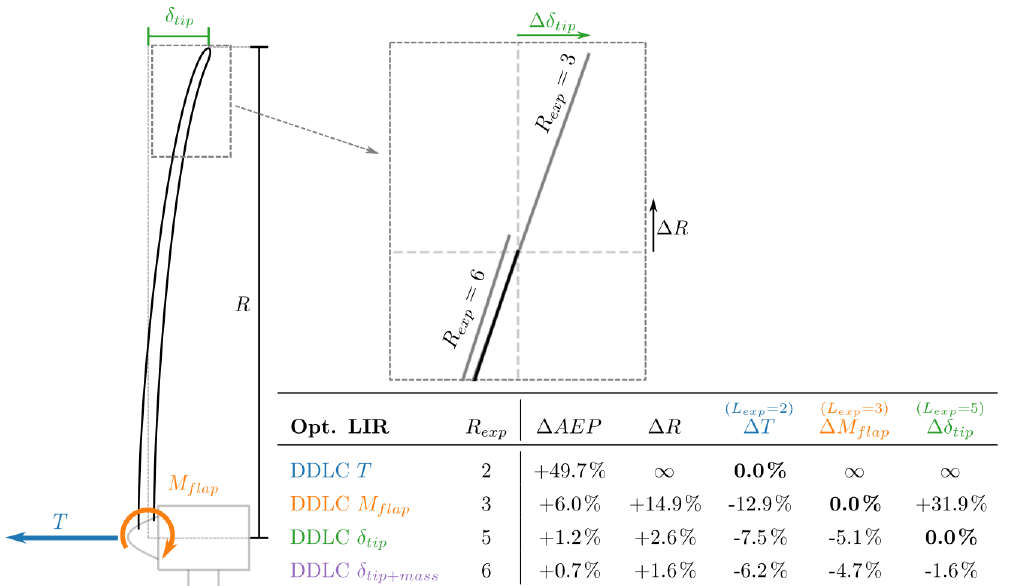
Figure 9. Sketch of a turbine with the load/structural response outlined. The zoomed-in figure shows the radius increase ( (cid:49)R ) and the change in tip deflection ( (cid:49)δ tip ) for two different DDLCs (bold black line is the baseline). The table shows the relative change in power, radius and load/structural response for different DDLCs. R exp = 2 is a thrust constraint design, R exp = 3 is a flap moment constraint design, R exp = 5 is a tip-deflection constraint design and R exp = 6 is the tip deflection+constant mass constraint design.